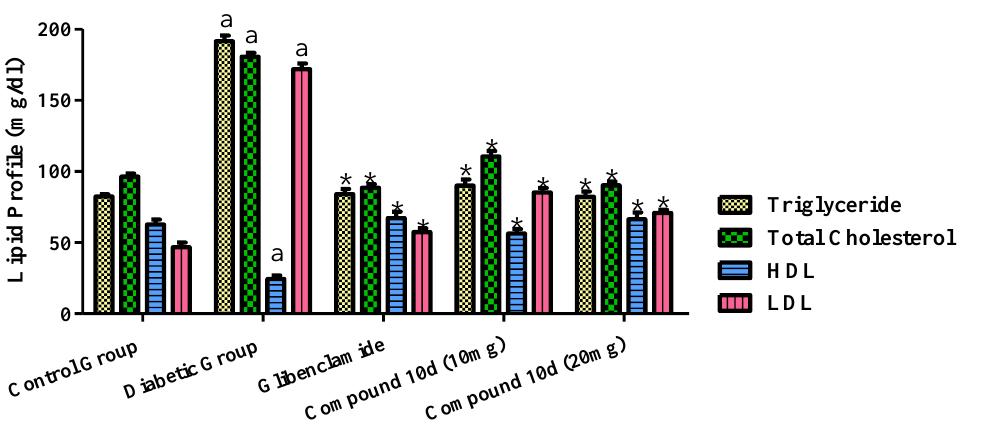
Figure 6. Effect of tested compound 10d on lipid profile. Values were presented as mean ± SEM (number of animals, n = 6) and were significantly different at a p < 0.05 in comparison to normal control group, * p < 0.05 when compared with diabetic control group.